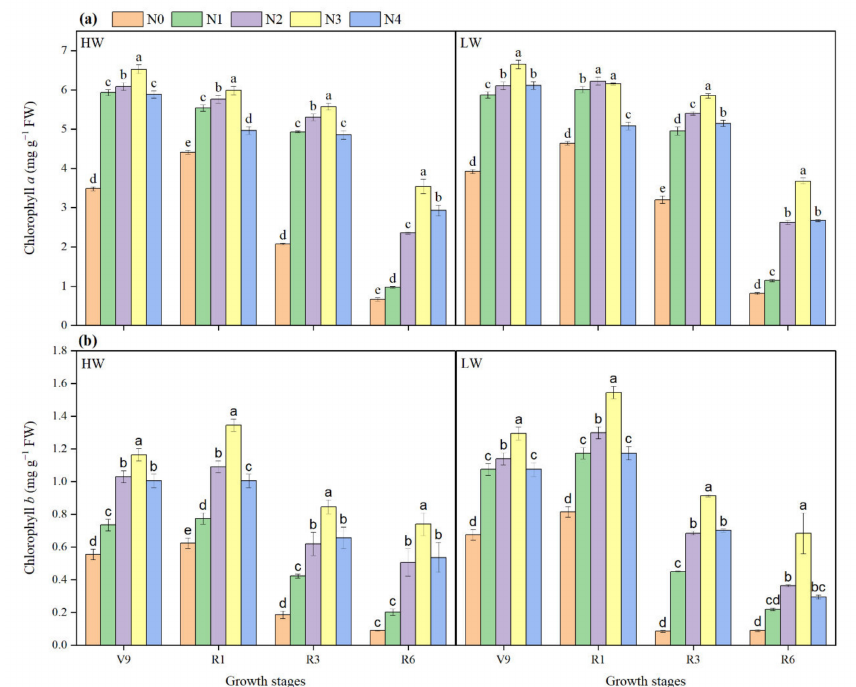
Figure 3. Effect of irrigation and nitrogen rates on chlorophyll a content ( a ) and chlorophyll b contents ( b ). HW and LW represent irrigation water at the rate of 80 and 60% of field capacity. Means followed by different lowercase letters within each treatment indicate significant differences ( p < 0.05). Bars represent standard errors. The nitrogen treatments N0, N1, N2, N3 and N4 represent the application of nitrogen at the rates of 0, 200, 250, 300 and 350 kg ha − 1 .